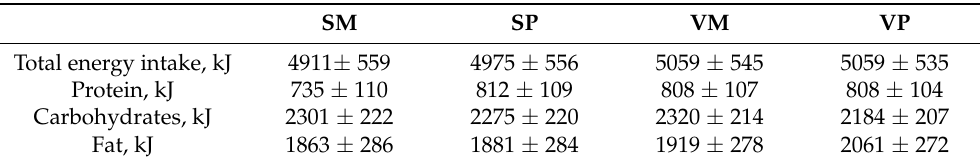
Table 4. Ad libitum energy intake after the four different test meals 1